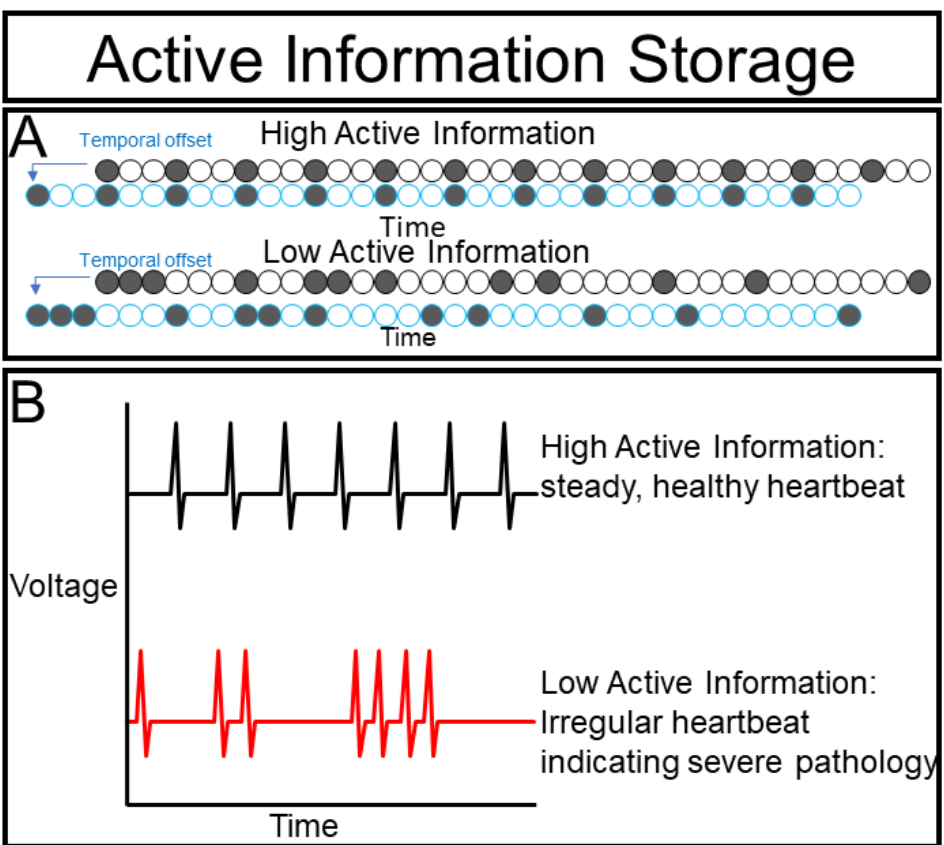
Figure 6. Active information storage: ( A ) Active information storage measures how well a variable’s past predicts its current state; ( B ) a healthy heart should have relatively high active information storage, while an unhealthy heart in which periodicity is pathologically perturbed show have lower AIS. High AIS values, therefore, may suggest that cells are behaving more independently and less collectively. If this is true, then, experimentally isolating the cells should have